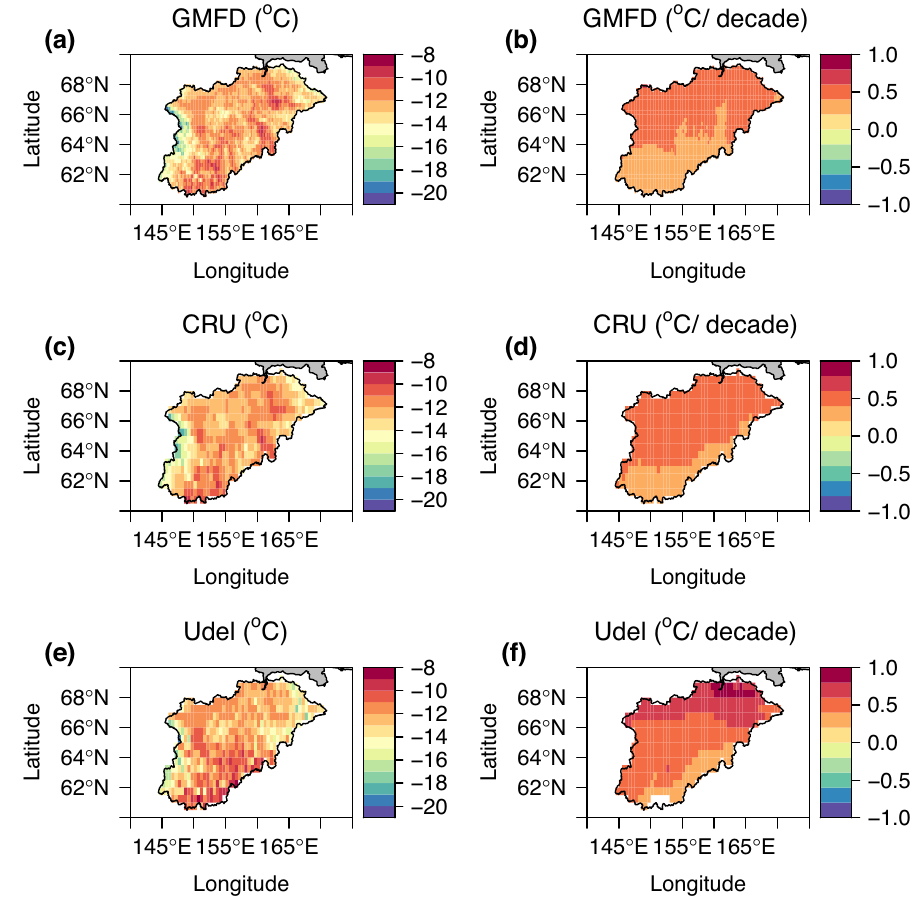
Figure 3. Climatology and trend in annual mean air temperature using three different forcing datasets. Climatology derived from ( a ) GMFD; ( c ) Climatic Research Unit (CRU), and ( e ) University of Delaware (Udel) and linear trend with statistical significance ( p < 0.05) derived from ( b ) GMFD; ( d ) CRU, and ( f )